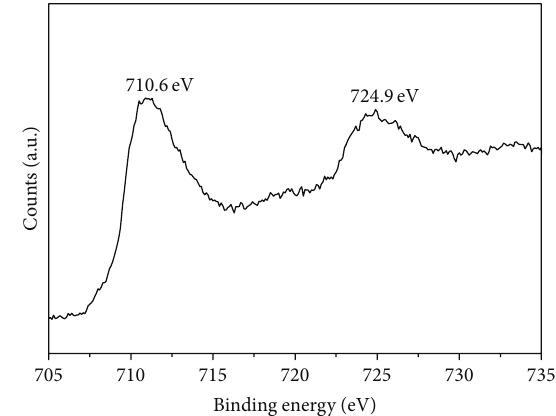
Figure2:Fe2pXPSspectrumofas-synthesizeddodecahedralFe 3 O 4